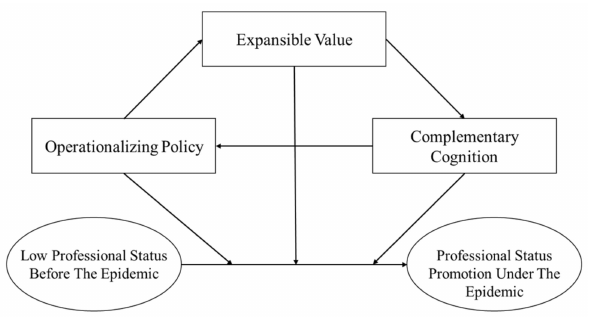
Figure 1. The mechanism of the promotion of the professional status of social